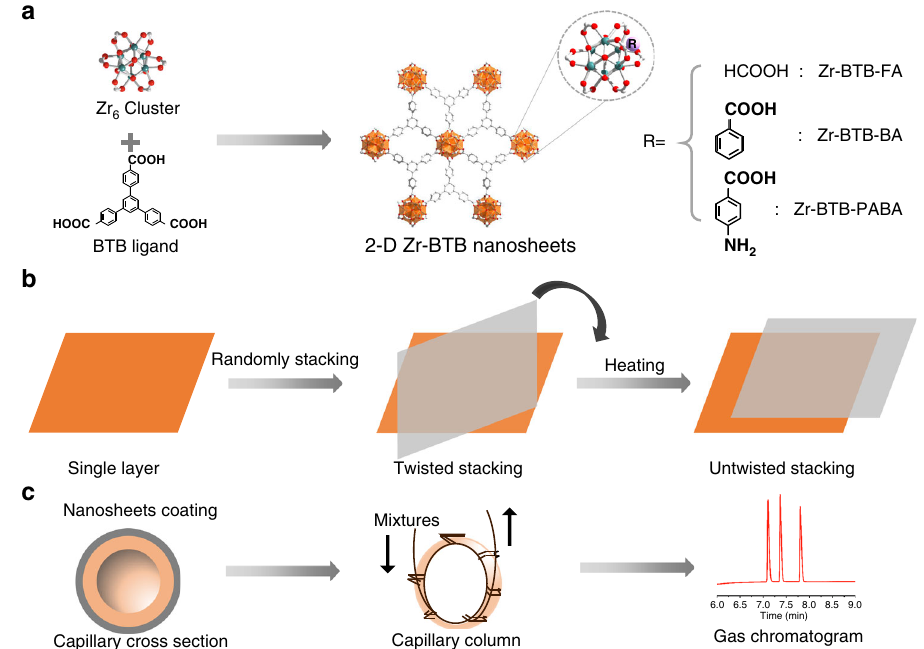
Fig. 1 Functionalized Zr-BTB nanosheets with untwisted stacking mode for chromatographic separation. a Synthesis of 2-D Zr-BTB nanosheets with different functionalities via coordination assembling from Zr 6 clusters and BTB ligands. b Twisted mode between adjacent layers is obtained by randomly stacking, while untwisted mode is generated by heating the twisted nanosheets. c Fabrication of Zr-BTB nanosheets coated capillary column for the gas chromatographic separation of isomer mixtures